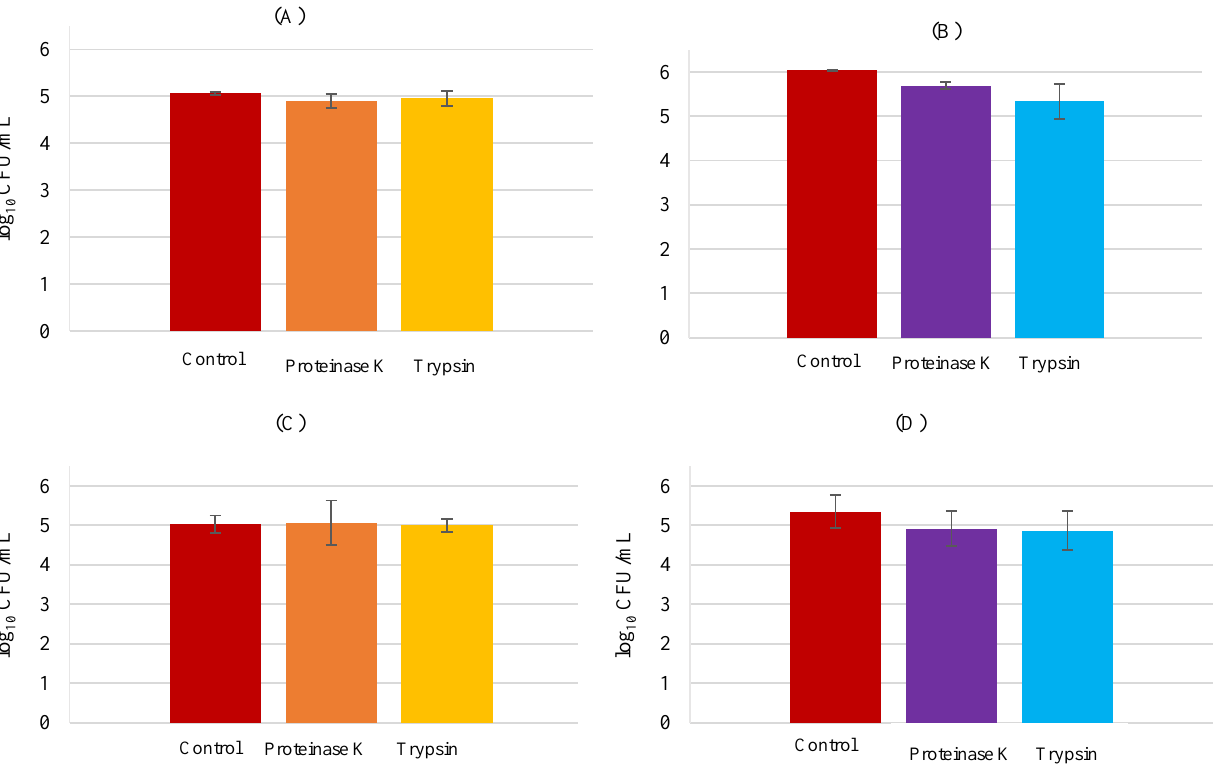
Figure 9. Protein analysis in adhesion to HaCaT; L . rhamnosus ( A ) S . aureus ( B ) L . rhamnosus plus S . aureus , MRS counts ( C ) L . rhamnosus plus S . aureus , BHI counts ( D ). Error bars are ± standard deviation.